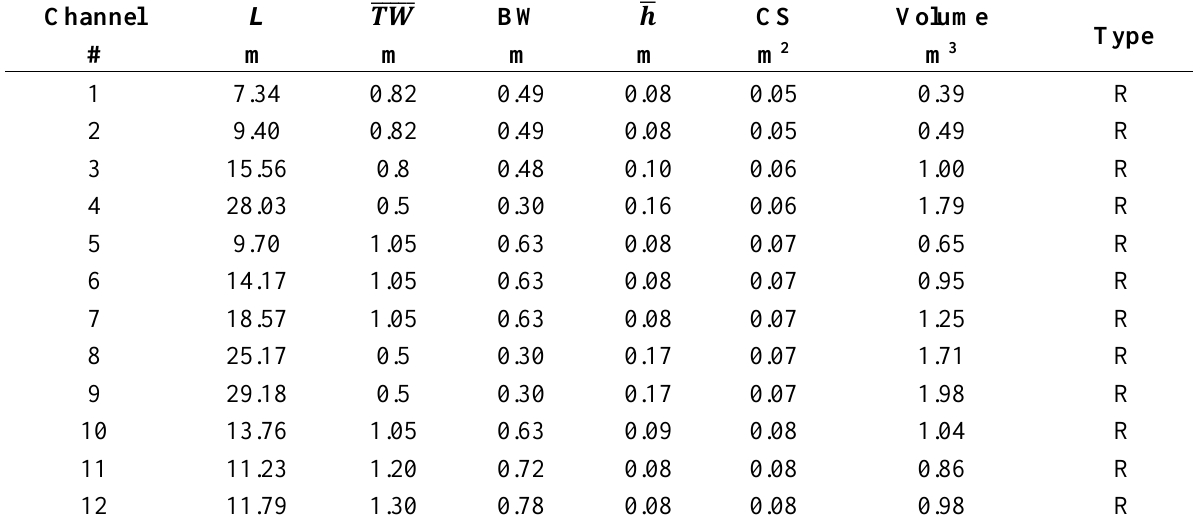
Table 2. Measurements of the 55 channels that were obtained from the stereo satellite